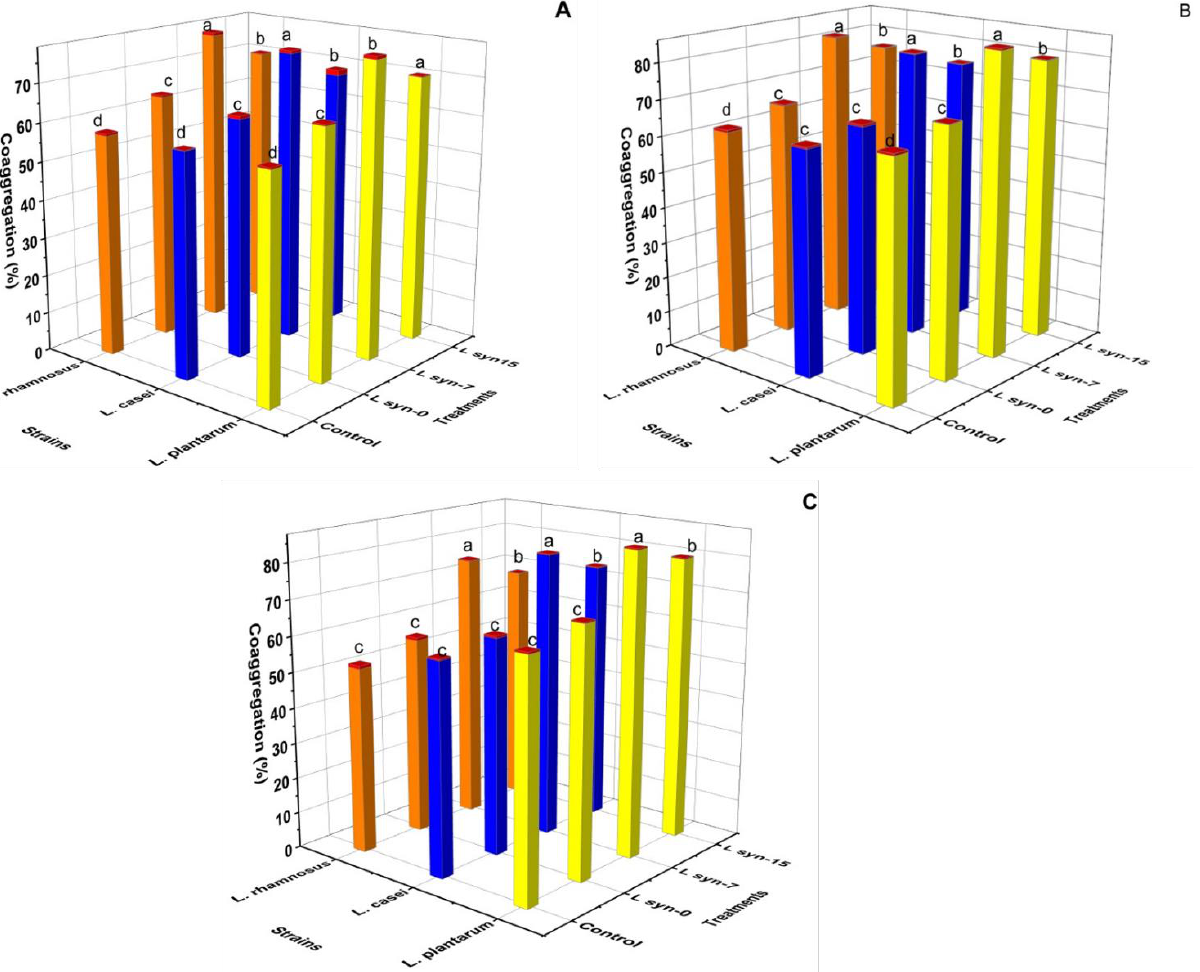
Figure 3. The effect of postbiotics (L syn-0 , L syn-7 and L syn-15 ) on the ability of selected probiotic strains to co-aggregate with foodborne pathogenic bacteria , L. monocytogenes ( A ), S. Typhimurium ( B ), S. aureus ( C ) after three hours incubation at 37 °C. Different letters indicate significant differences at p < 0.05. Redcaps of the columns show the standard division of the sample’s mean.